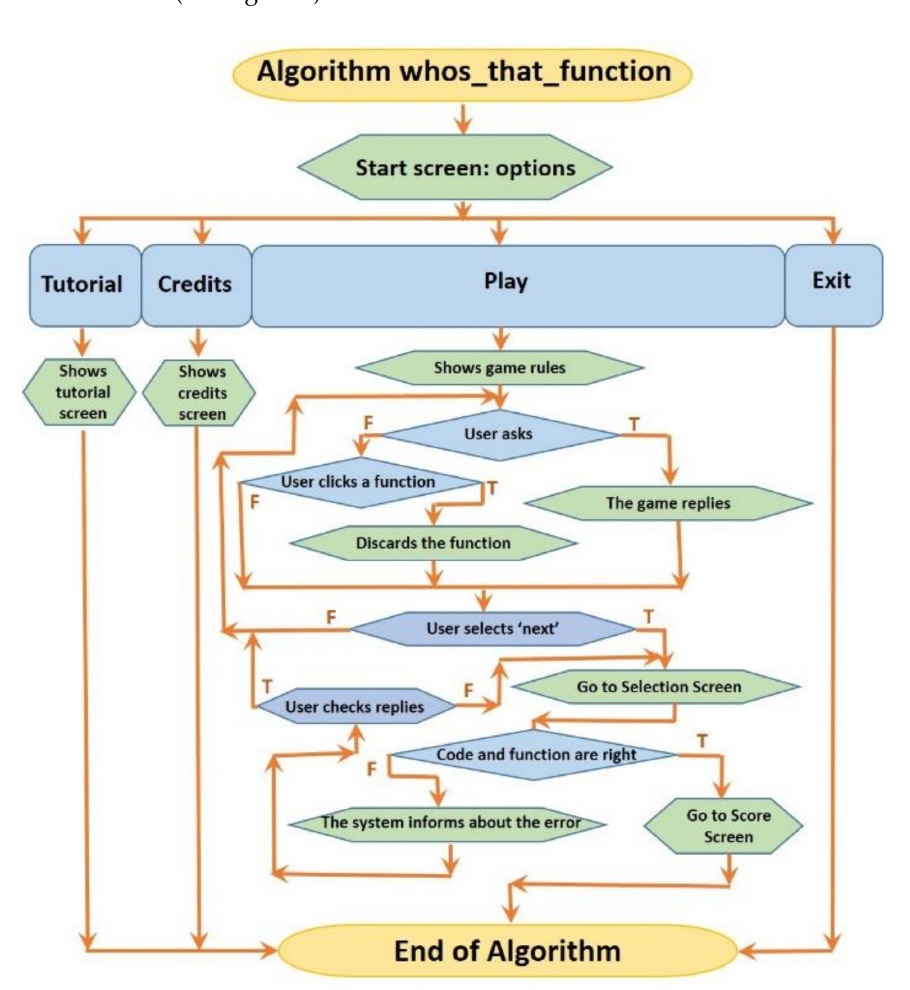
Figure 8. Flow chart for the “Who’s That Function” online